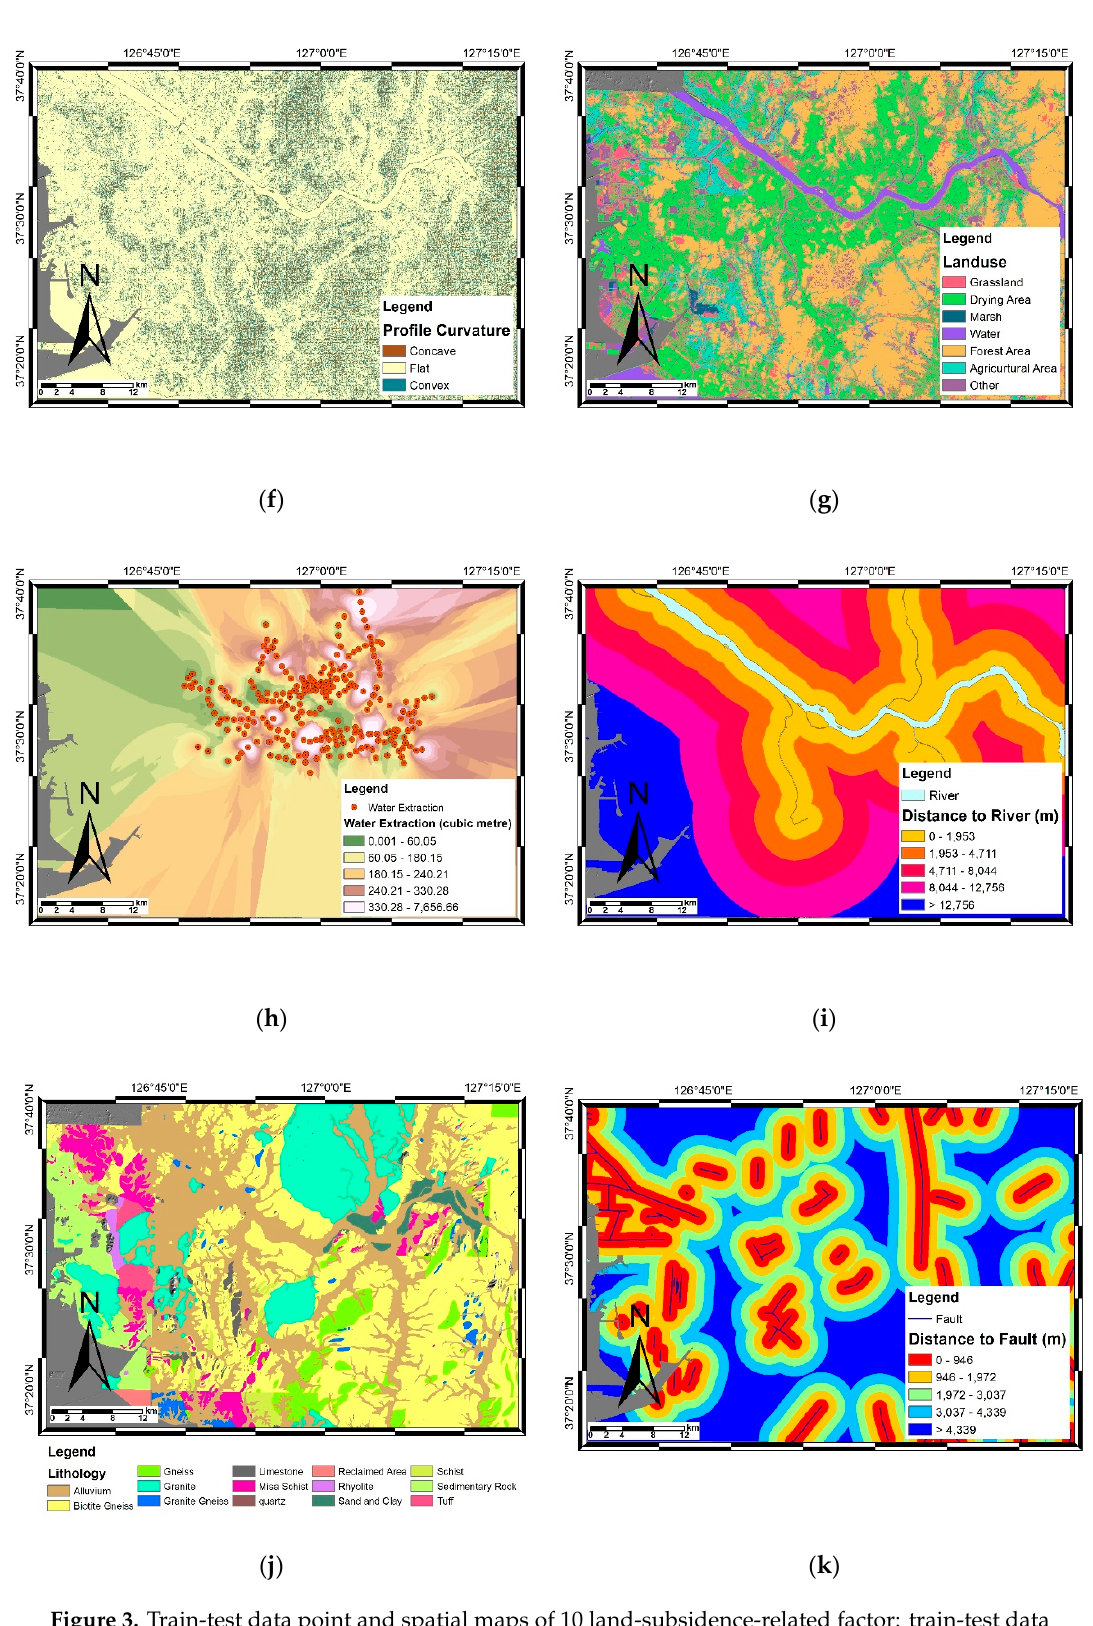
Figure 3. Train-test data point and spatial maps of 10 land-subsidence-related factor: train-test data point ( a ), elevation ( b ), slope ( c ), aspect ( d ), topographic wetness index (TWI) ( e ), profile curvature ( f ), land use ( g ), groundwater extraction ( h ), distance to river ( i ), lithology ( j ), and distance to fault ( k ).